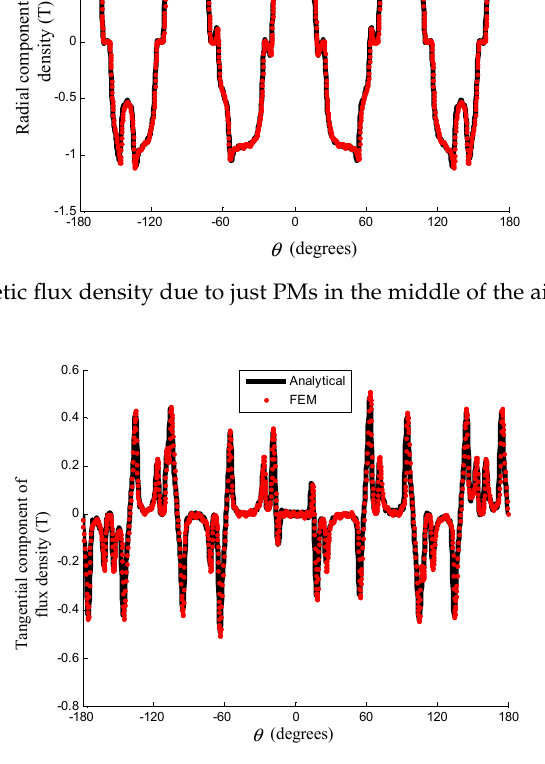
Figure 7. Tangential magnetic flux density due to just PMs in the middle of the air-gap, when the rotor position is set to zero.